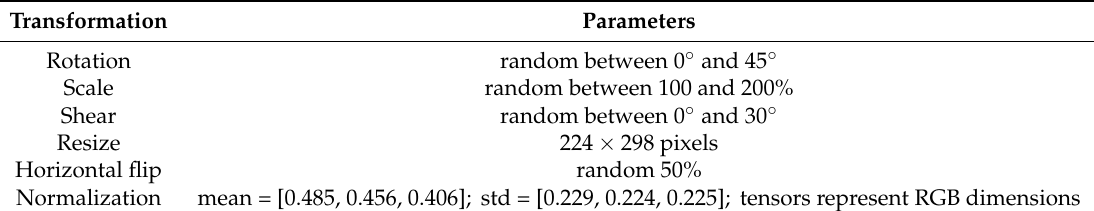
Table 1. Image transformations used for dataset